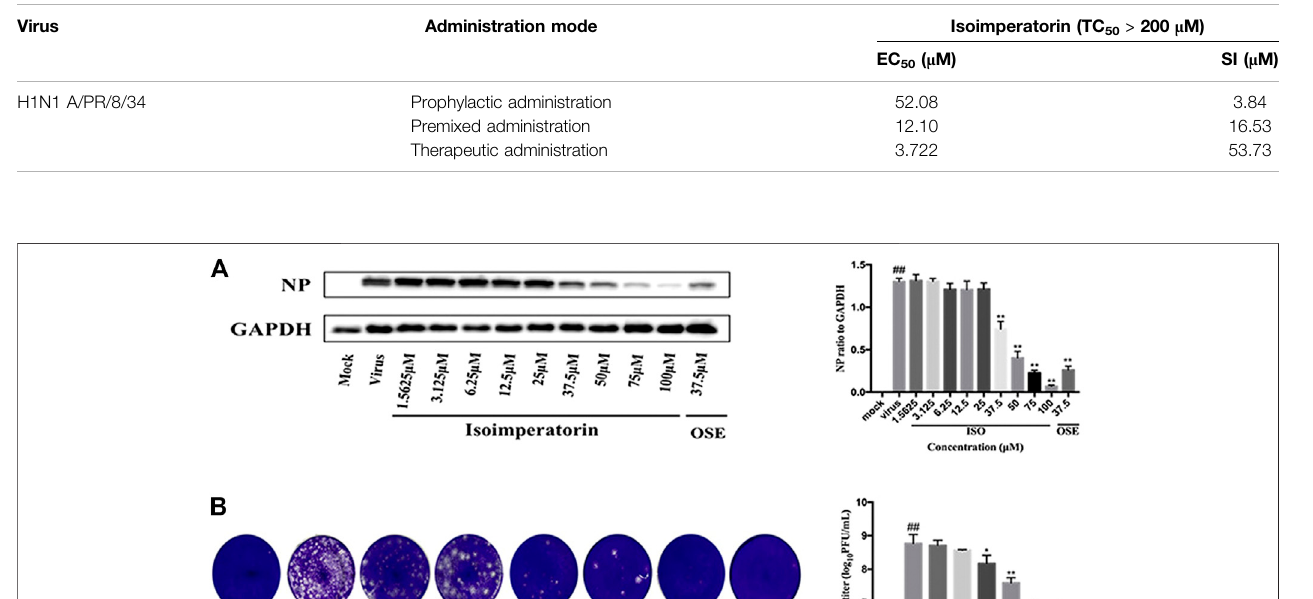
Frontiers in Pharmacology |